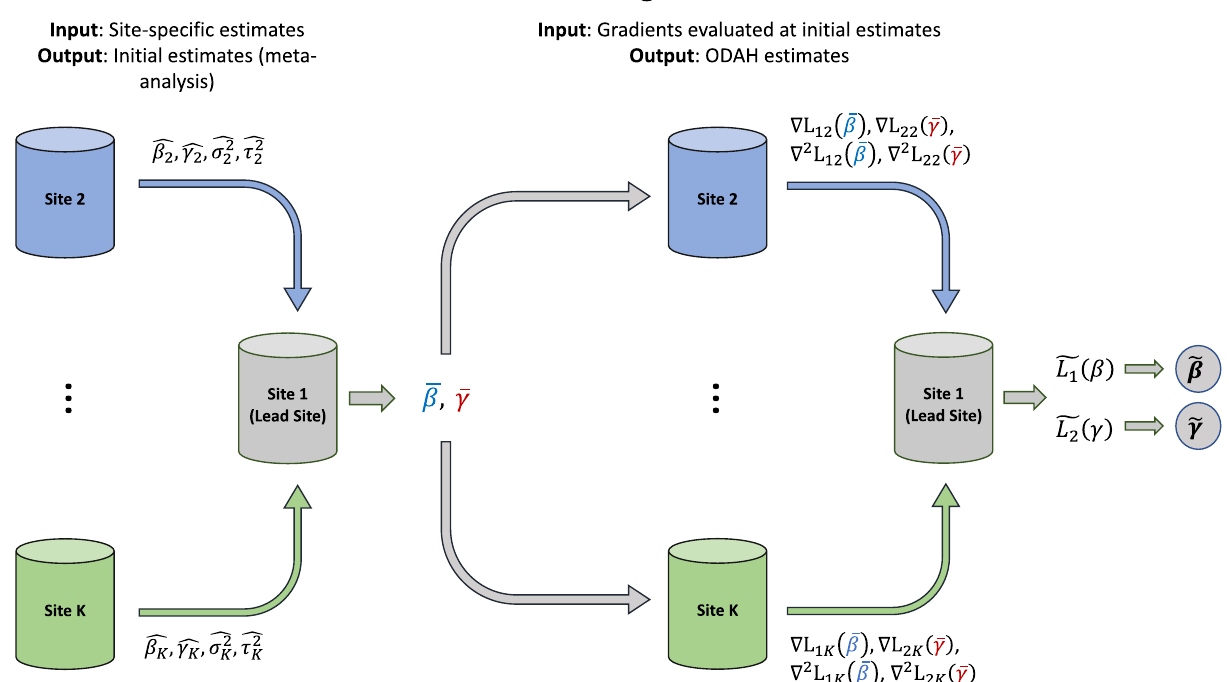
Figure 2. Visual representation of one-shot distributed algorithm for hurdle regression (ODAH). In the initialization round, coefficient ( ˆ β i , ˆ γ i ) and variance ( ˆ σ 2 i , ˆ τ 2 i ) estimates from fitting separate hurdle models at each collaborating site are sent to the lead site; these estimates are then used together with lead site estimates in a meta-analysis to produce initial estimates ( β , γ ) for ODAH, which are sent to each collaborating site. In the surrogate likelihood estimation round, first-order ( ∇ L 1 i , ∇ L 2 i ) and second-order ( ∇ 2 L 1 i , ∇ 2 L 2 i ) gradients are computed at each site, evaluated at the received initial estimates and sent to the lead site. These gradients are used in conjunction with data from the lead site to construct surrogate likelihood functions ˜ L 1 (β) and ˜ L 2 (γ) , which are then maximized to produce surrogate maximum likelihood estimates ˜ β and ˜ γ